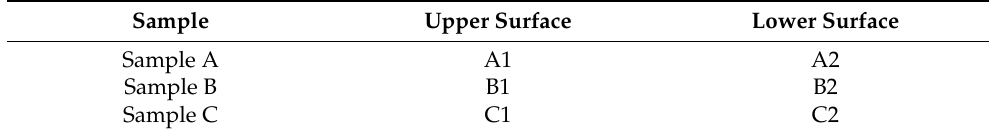
Table 2. Sample number of all sheds.